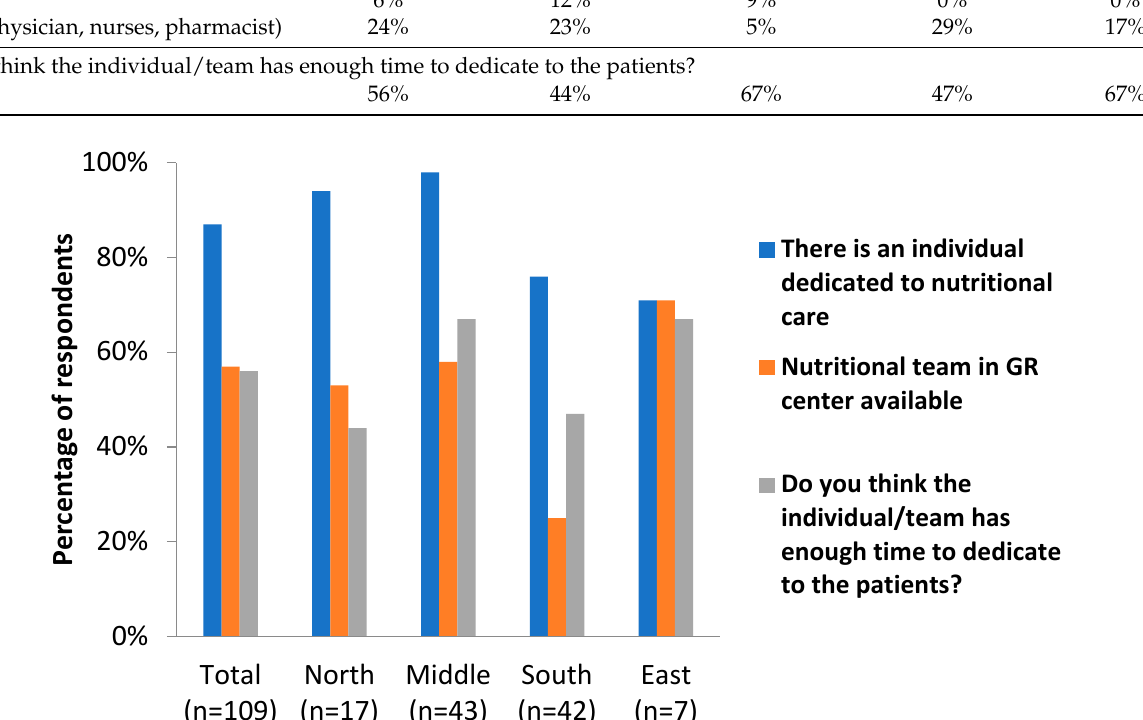
Figure 1. Dedicated nutritional care in GR centers in different geographical areas of Europe. Table 2. Dedicated nutritional care in GR centers.